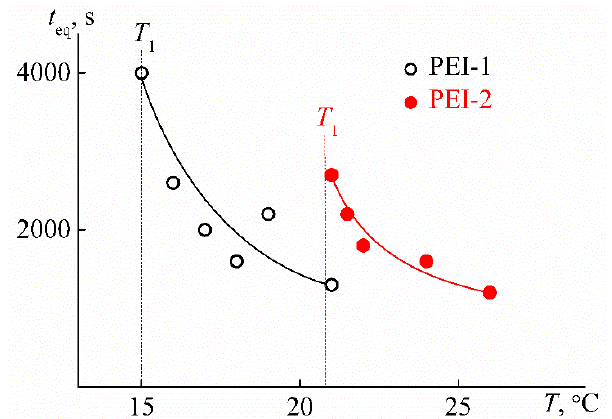
Figure 16. Dependencies of time t eq on temperature T for solutions of PEI-1 and PEI-2 at c = 0.0280 g cm –3 .